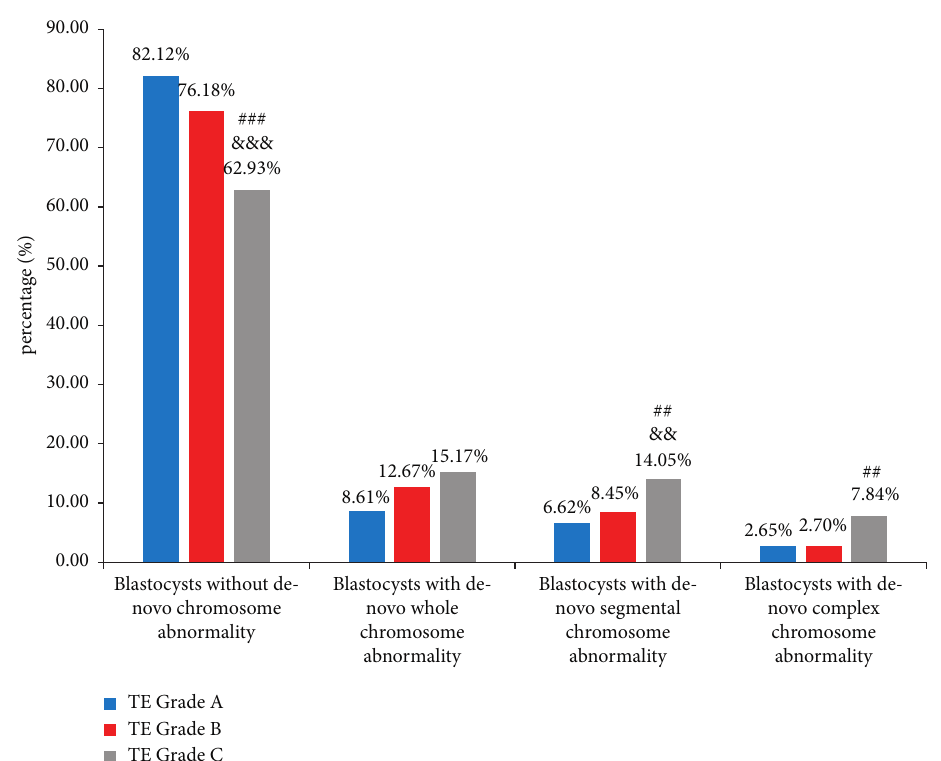
Figure 2: The proportion of blastocysts with different genetic test results related to TE quality. Data were presented as a percentage. Blastocysts without de novo chromosome abnormality contained euploid, mosaic and chromosome abnormalities inherited from either parent. The proportions between the three groups were tested by the chi-square test. ### P < 0.001 vs TE grade B, &&& P < 0.001 vs TE grade A, ## P < 0.01 vs TE grade B, and && P < 0.01 vs TE grade